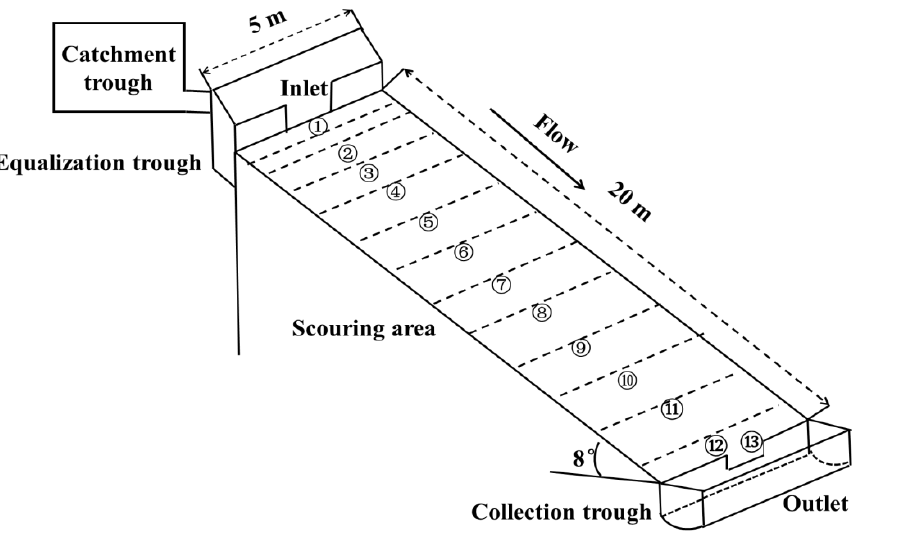
Figure 2. Sketch of the simulated scouring experiment with two plots (note that ① – ⑬ are the observation cross-sections).